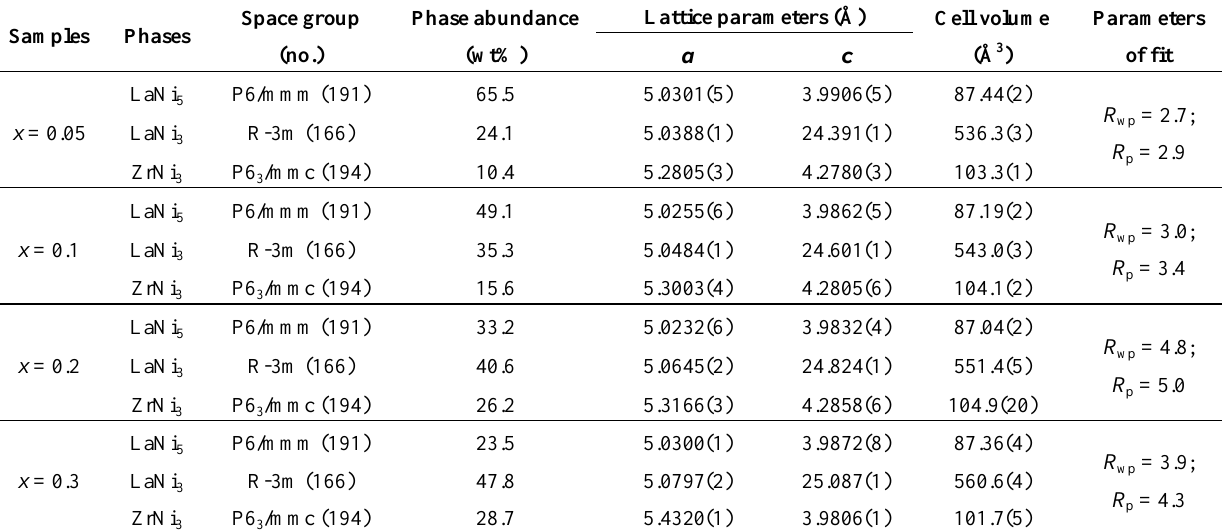
(Mg Zr )(Ni Co ) alloys. 0.7 0.3– x x 0.85 0.15 3.5 (Mg Zr )(Ni Co ) 0.7 0.3– x x 0.85 0.15 3.5